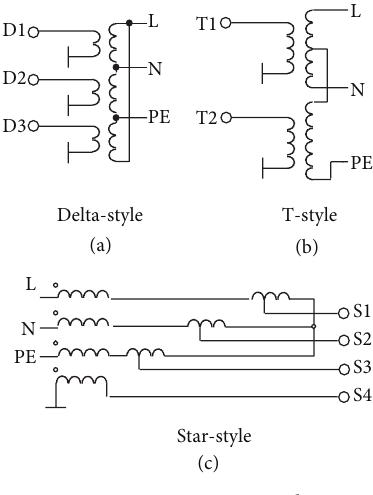
Figure 3: MIMO PLC